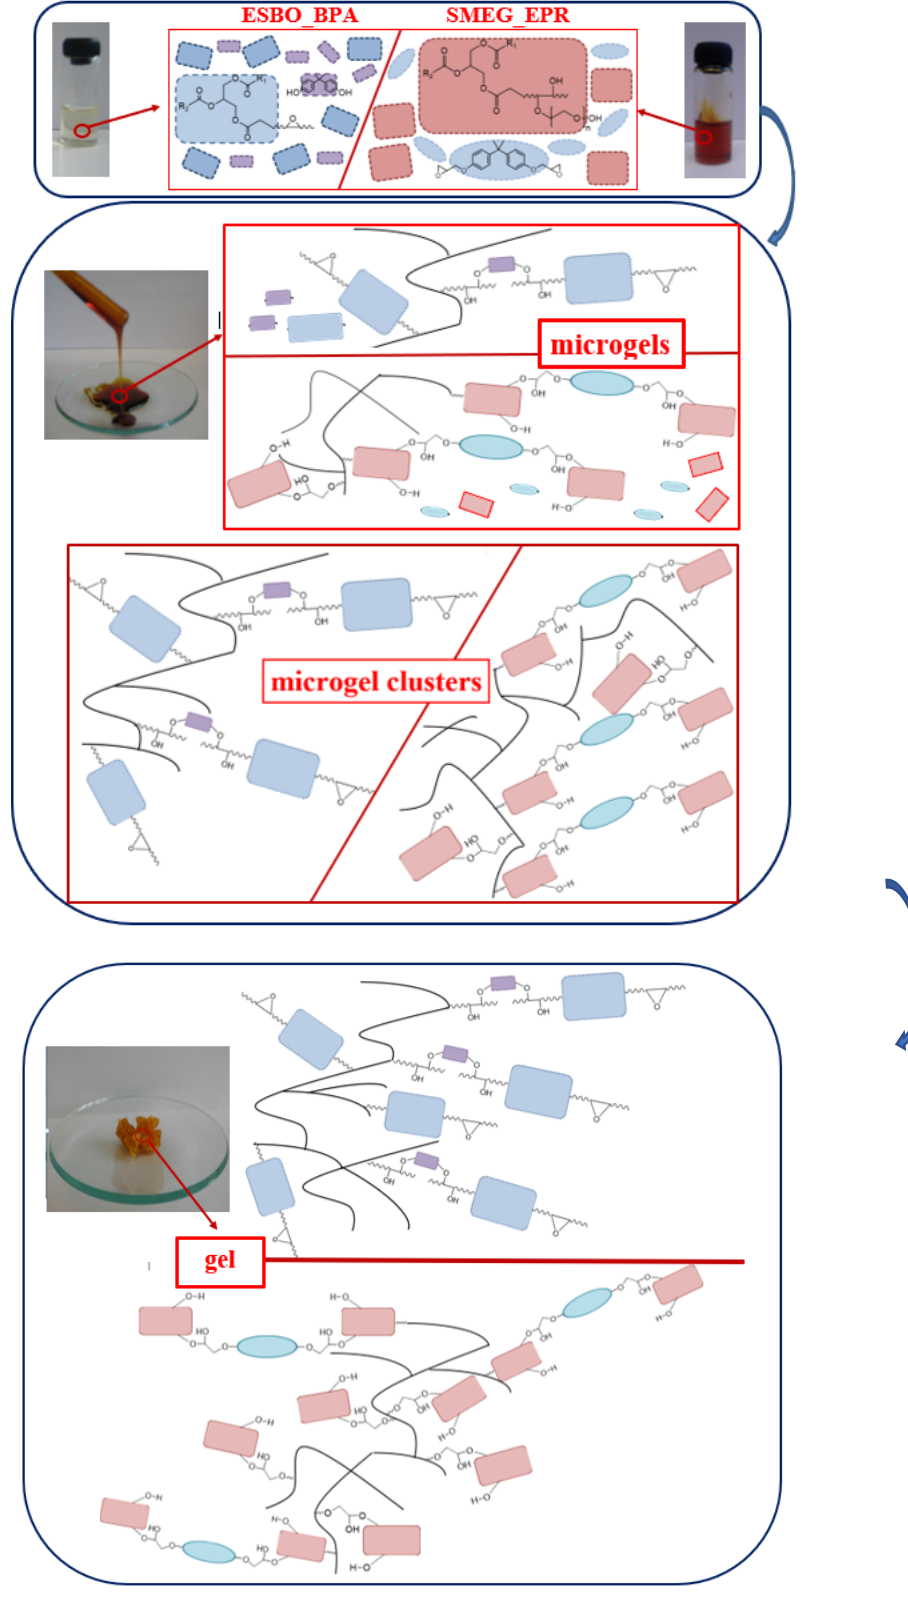
Figure 6. The course of changes, which are taking place during the polyaddition process from the beginning of the process until the gelation of the reaction mixture.